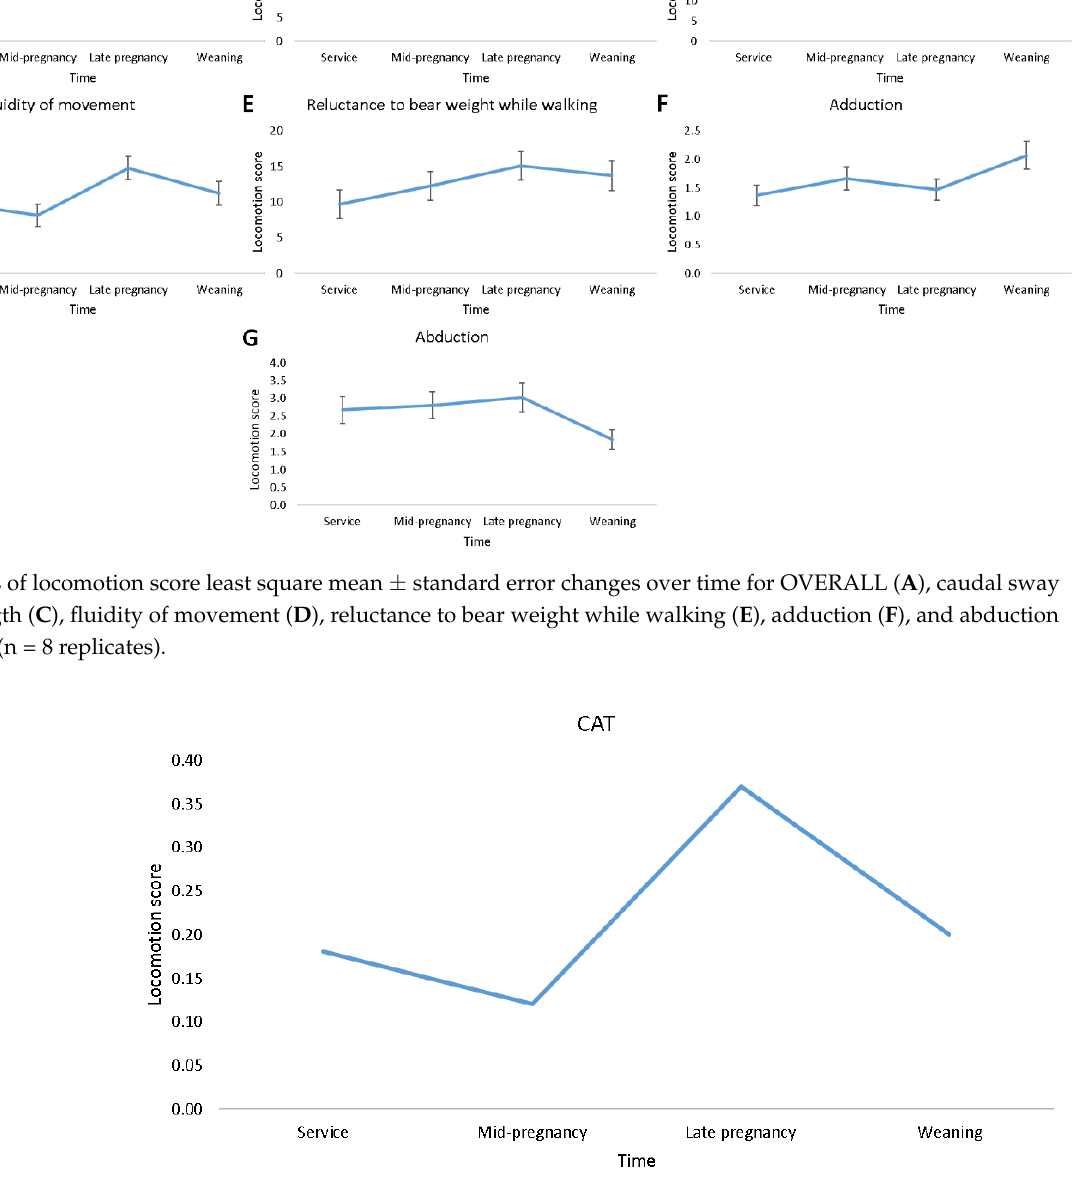
Figure 3. Plot of CAT mean locomotion score changes over time in 51 gilts (n = 8 replicates).